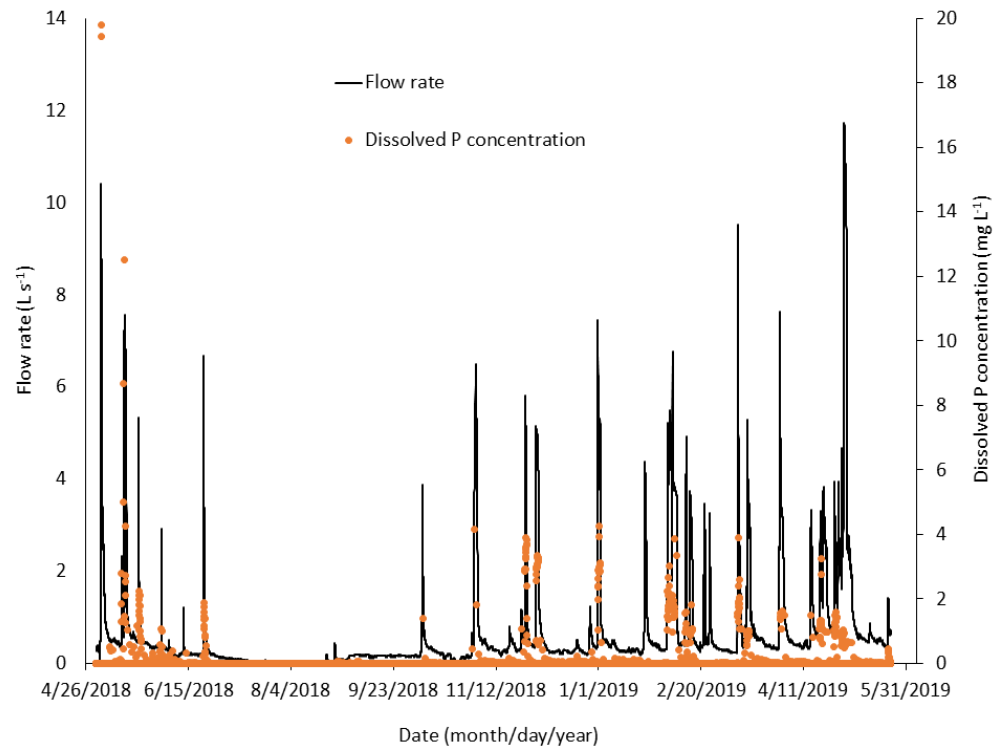
Figure 4. Hydrograph and associated inflow dissolved phosphorus (P) concentrations measured at the inlet of the subsurface tile drain P removal structure shown in Figure 1.